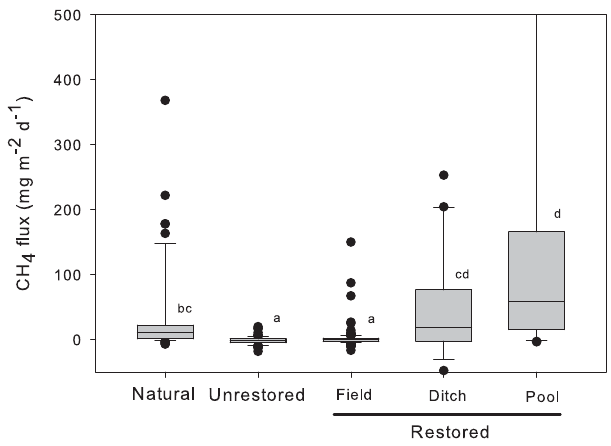
Fig. 5. Methane flux from natural, unrestored and restored plots dur- ing the growing season (May–October). Box plots indicate 10th and 90th percentile with bars, 25th and 75th percentiles with top and bottom of box and median with centerline. Medians are significantly different from each other if they share no letters in